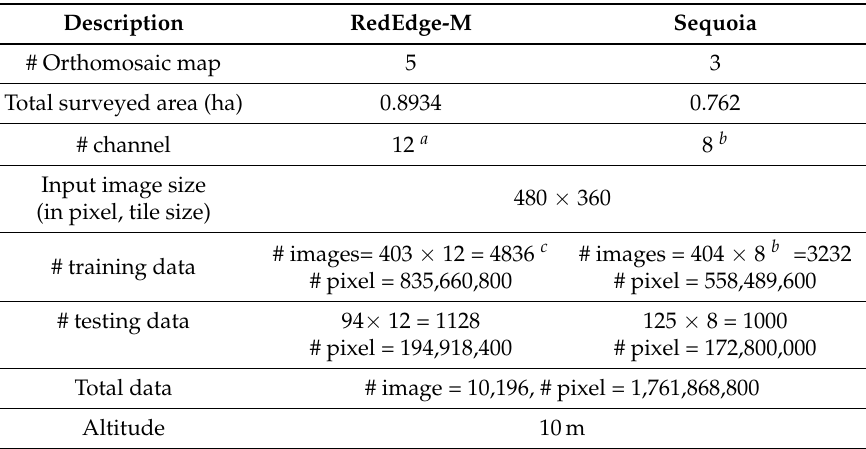
Table 4. Overview of training and testing